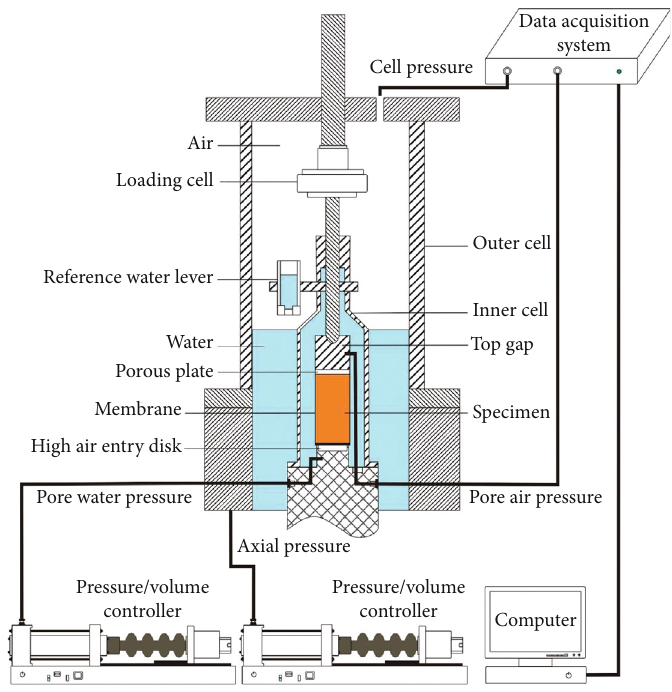
Figure 1: The GDS unsaturated triaxial test